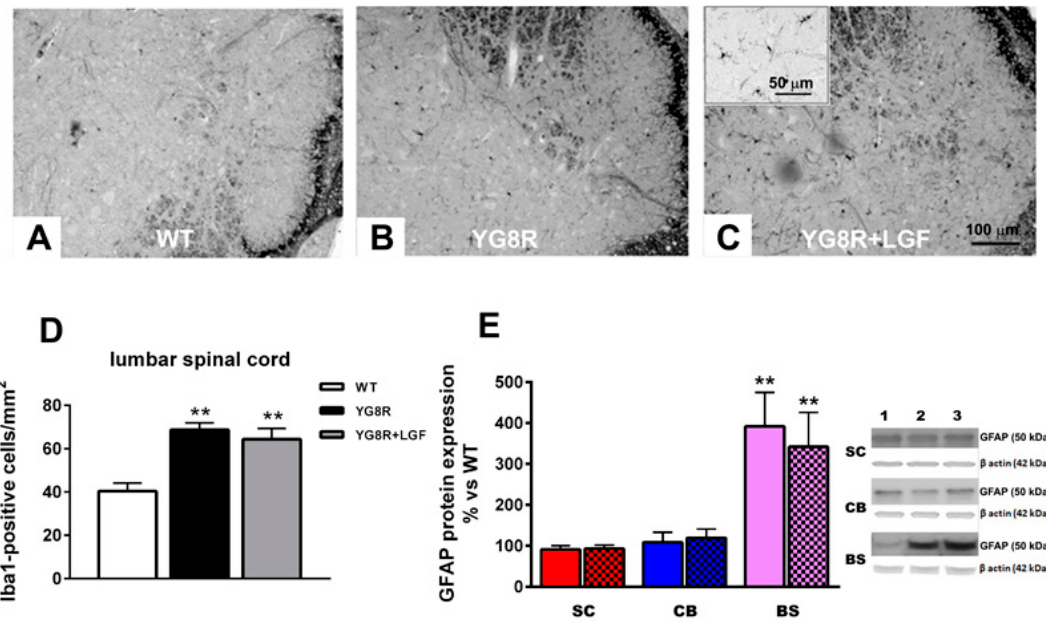
Figure 3. Effect of LGF treatment in microglia and Glial Fibrillary Acidic Protein (GFAP) protein expression. The upper panel depicts activated microglia stained for Iba1 ( brown ) in the lumbar spinal cord of WT ( A ), YG8R ( B ), and YG8R+LGF mice ( C ); The inset in C shows Iba1-positive cells at higher magnification; ( D ) Represents the quantification of these cells, revealing a significant increase in YG8R ( black bar) and YG8R+LGF mice ( gray bar) versus WT ( white bar); ( E ) Shows the effect of LGF treatment on GFAP expression, detected by western blot in the spinal cord (SC, red bars), cerebellum (CB, blue bars), and brain stem (BS, lilac bars) of YG8R ( uniform bars) and YG8R+LGF (bars with mesh ). Note how GFAP levels are upregulated in the BS of YG8R and YG8R+LGF mice. Lane 1 (WT), Lane 2 (YG8R), Lane 3 (YG8R+LGF). Results are the mean ± SEM of three (in the case of the spinal cord) or six (in the rest of structures) independent animals. ** p < 0.01 vs. WT.